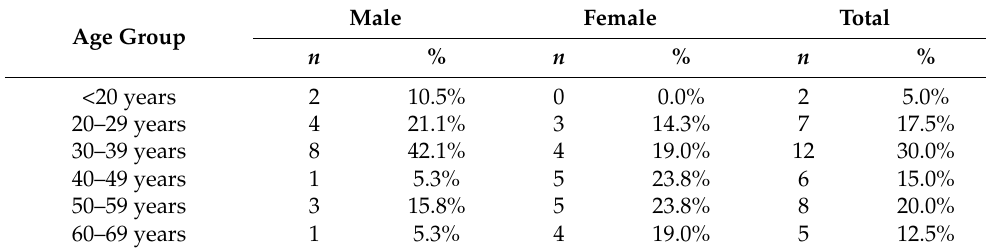
Table 2. Structure group by age group and